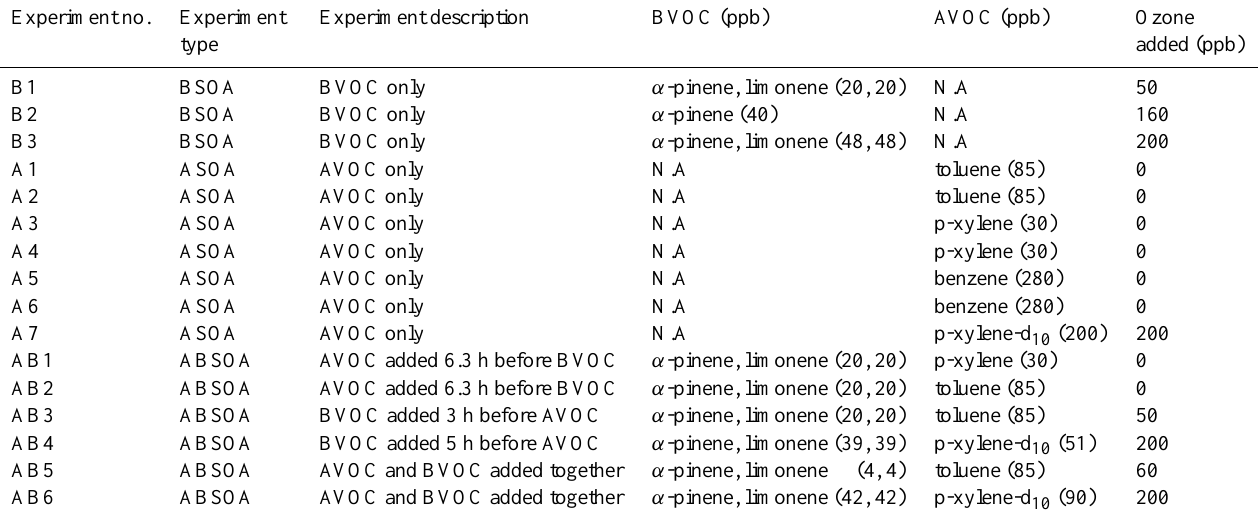
Table 1. Summary of the experiments in this study. Experiment